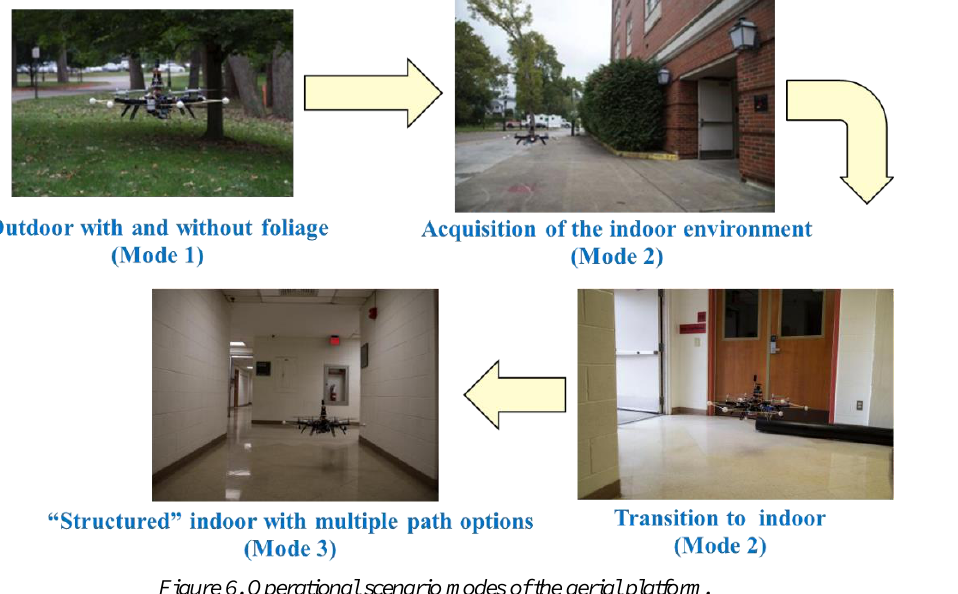
Figure 6. Operational scenario modes of the aerial